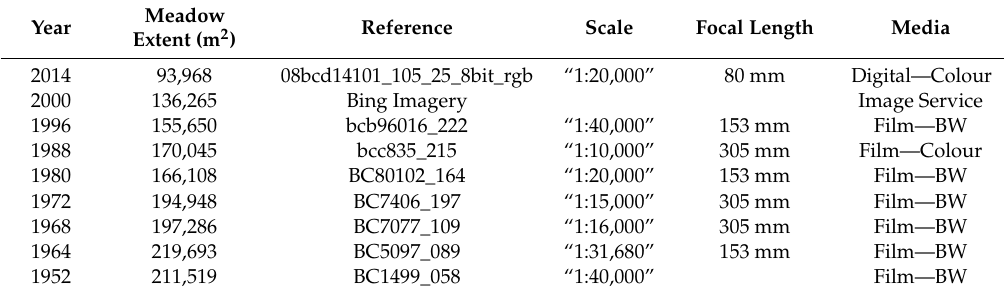
Table 1. The year, scale, focal length, media type, and source of air imagery used to map spatial changes in the historic Garry oak meadow in Helliwell Provincial Park, British Columbia,